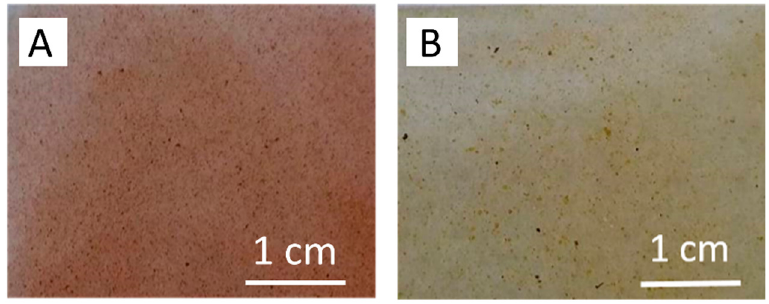
Figure 2. Optical micrographics of ET10 ( A ) and EP10 films ( B ).